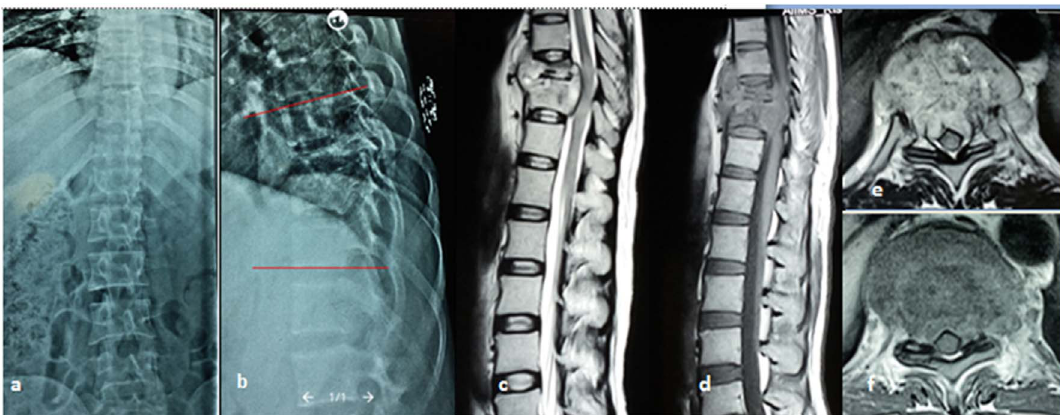
Bold values in Table 3 represent Odds ratio of variables that are signi fi cant.